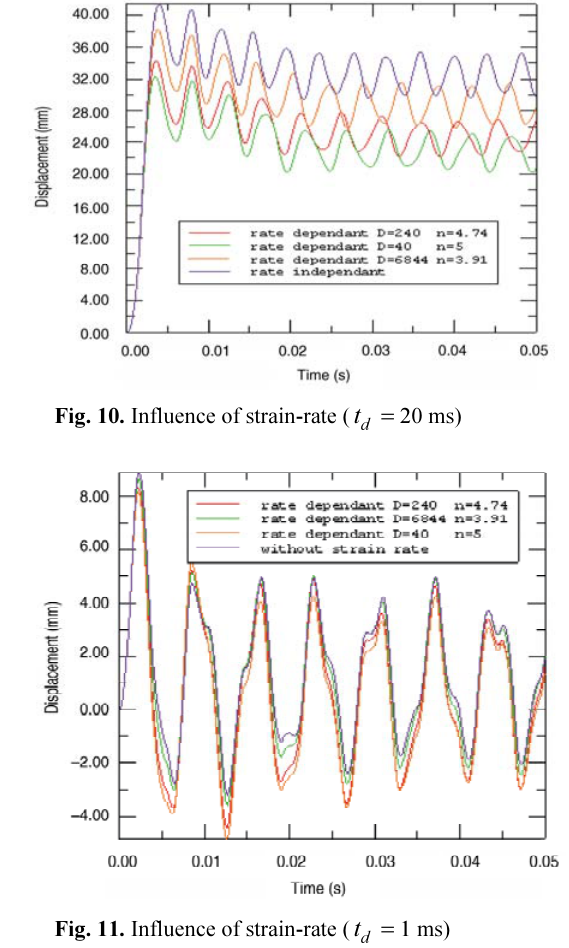
Fig. 11. Influence of strain-rate ( d